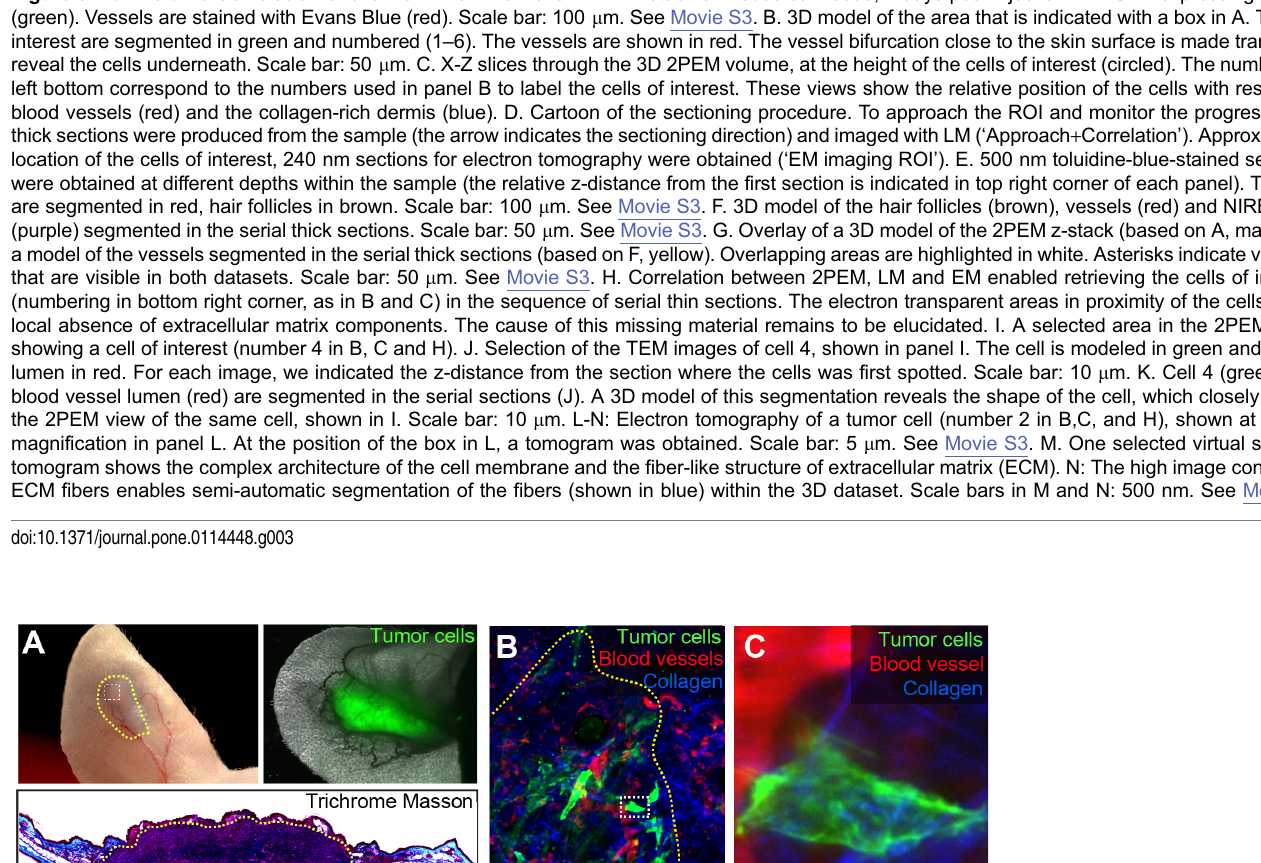
Figure 4. 2PEM Imaging of D2.0R Cells Xenotransplanted in Mouse Ear Skin. A. Two weeks after injection with LifeAct-Ypet expressing D2.0R cells, a tumor is formed in the mouse ear skin (top left panel, outlined in green). The green fluorescent signal of the D2.0R cells can be observed in the tumor region (top right panel). A histological cross-section through the tumor region was obtained from the second ear injected at the same time with the same cell type. The Trichrome Masson staining colors the collagen in blue (bottom panel). B. Maximum projection of a z-stack obtained from an area in the periphery of the invasive tumor (top left panel A, white square). The D2.0R cells are shown in green, and the tumor is outlined in yellow. A background signal from the Evans Blue (red) can be observed in the vicinity of the blood vessels, potentially caused by the ‘leaky’ nature of the tumor vessels, its uptake by residing immune cells and the repeated injections. Scale bar: 50 m m. See Movie S4. C. Higher magnification z-projection of the cell of interest boxed in B. Scale bar: 10 m m. D. Time-lapse imaging of a D2.0R tumor cell in vivo. The different panels depict, in black against a white background, the fluorescent signal of the actin in the cell at the indicated time-points. See Movie S4. E. Color-coded map of the structural changes of the cell of interest (boxed in B and C) over time. Scale bar: 10 m m.